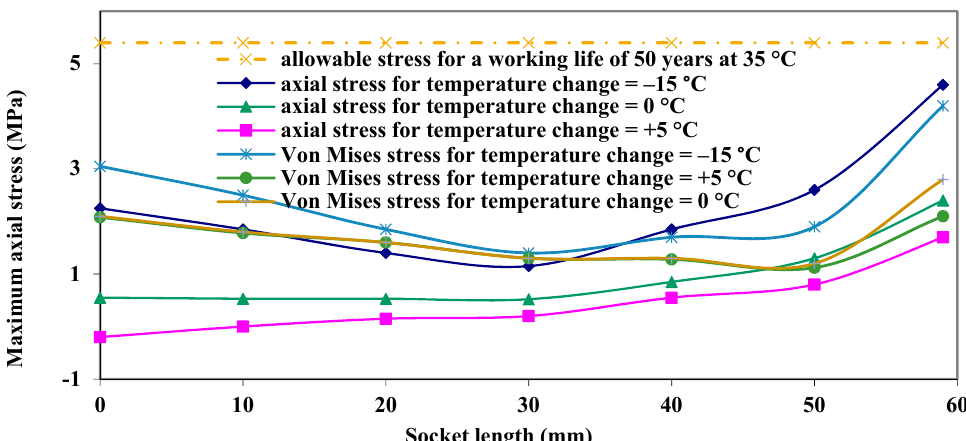
Figure 5. Maximum axial and Von Mises stress variations along the socket length (the simultaneous effect of soil load, internal pressure, vehicle wheel load and temperature variations).